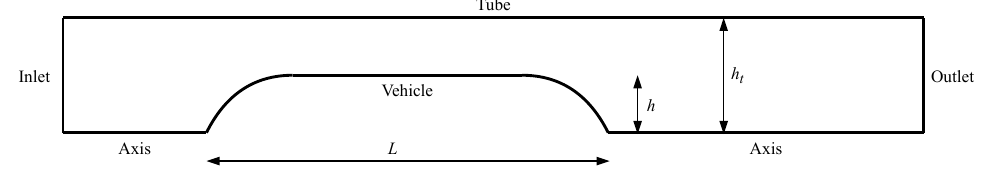
Figure 1. Drawing of the domain for the base case. Not to scale. Reference [15]. The nose and tail of the geometry are equivalent ellipses of 4.6 m long, and the intersection angle with the horizontal axis is 70 degrees. Both ellipses are tangent to the straight part of the vehicle, which measures 42.5 m